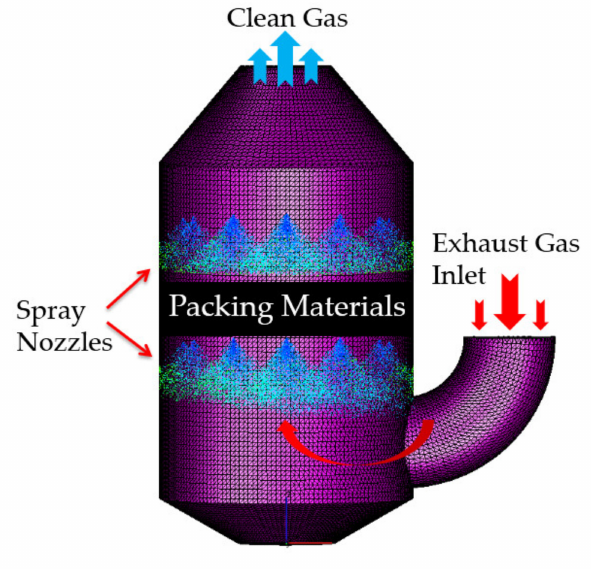
Figure 3. Simplified scrubber